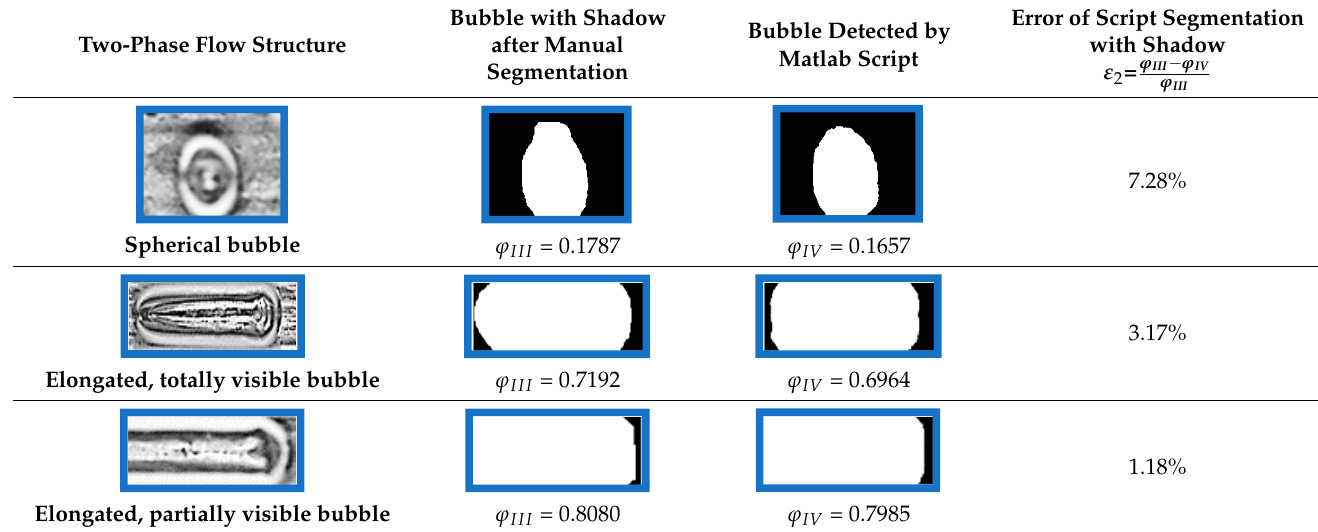
Table 3. Void fraction values after segmentation with shadow.